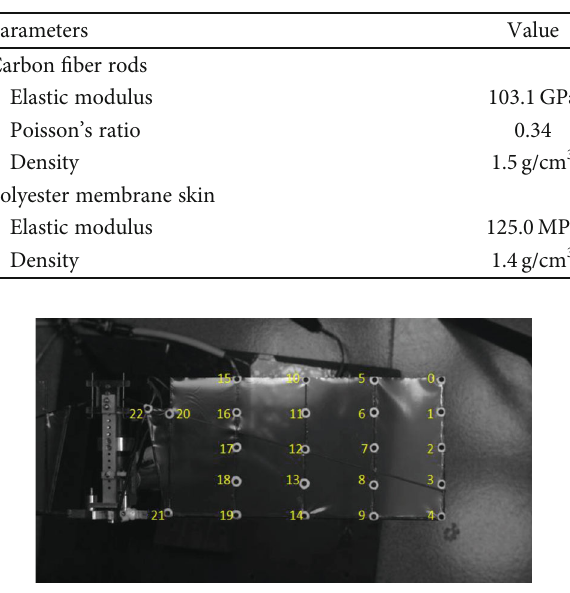
Figure 6: Instron 5848 machine and the testing samples. Table 1: Mechanical properties of the wing.